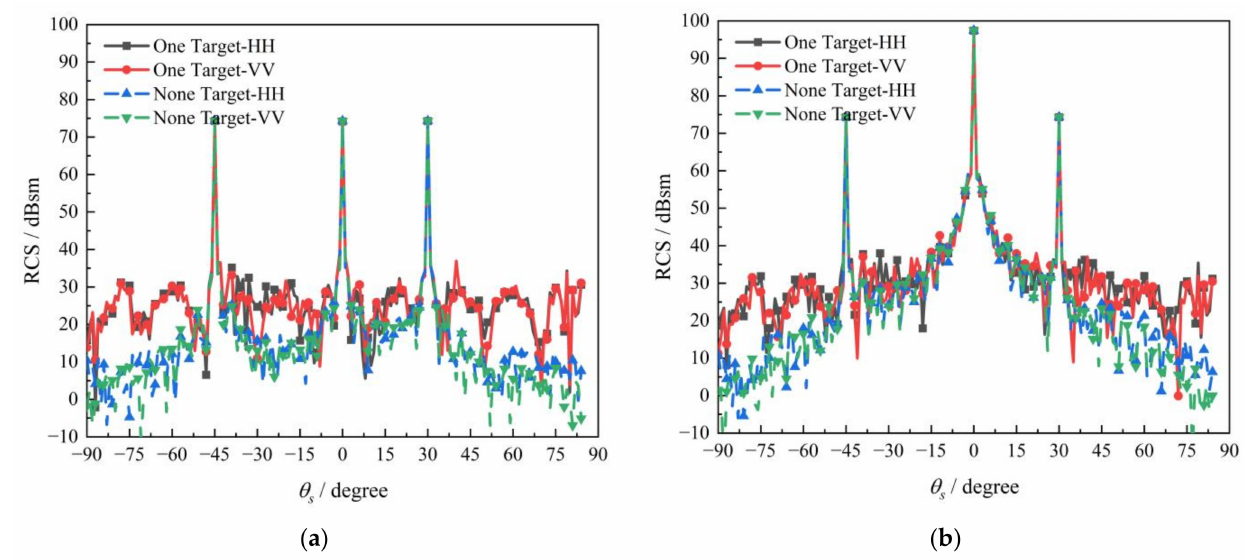
Figure 20. Monostatic RCS simulation results: ( a ) canyon composite rough surface; ( b ) valley composite rough